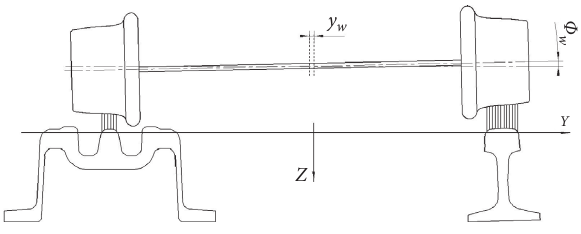
Figure 4: Determination of wheel-rail contact points.